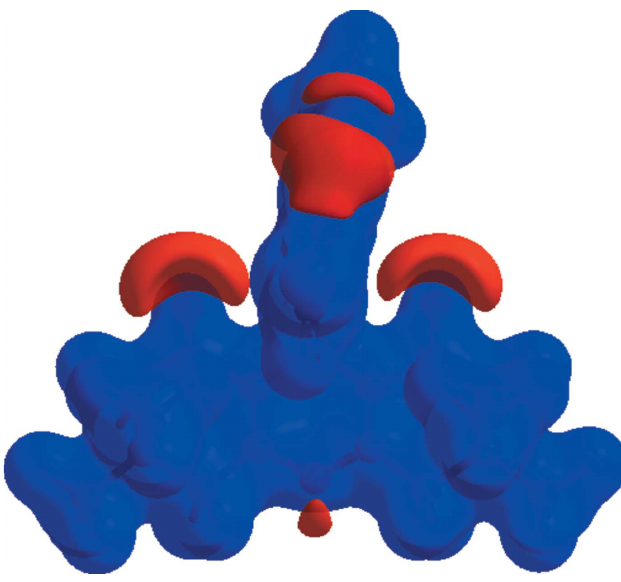
Figure 5 View of the three-dimensional Hirshfeld surface of (I) plotted over electrostatic potential energy in the range (cid:5) 0.0500 to 0.0500 a.u. using the STO-3 G basis set at the Hartree–Fock level of theory. The hydrogen- bond donors and acceptors are viewed as blue and red regions, respectively, around atoms, corresponding to positive and negative potentials.